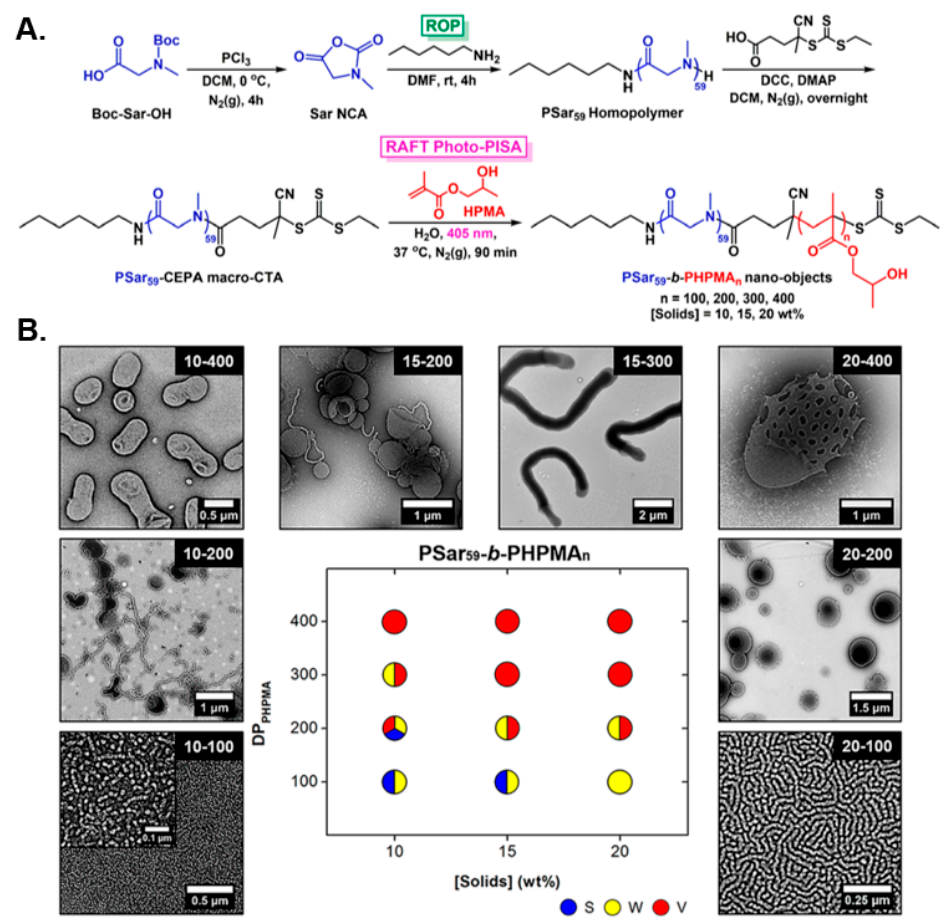
Figure 5. ( A ) Synthesis of PSar- b -PHPMA diblock copolymer nano-objects via aqueous RAFT-mediated photo-PISA. ( B ) Phase diagram and representative TEM images for PSar- b -PHPMA diblock copolymer nano-objects as a function of total solids concentration and core-block DP. Reproduced with permission from reference [89]. Copyright 2018 American Chemical Society.